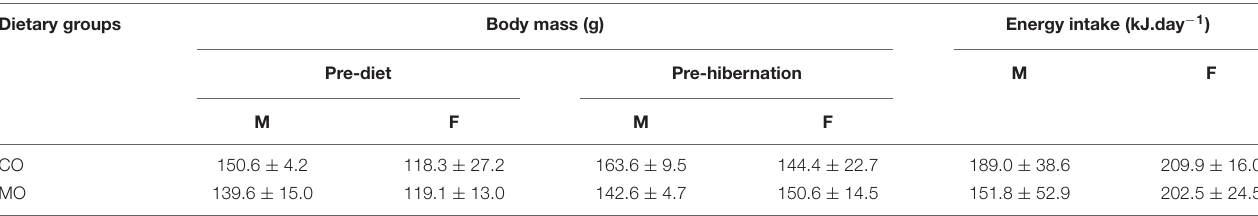
TABLE 3 | Body mass (means ± standard deviation) at the start of the diet treatment (“Pre-diet”) and prior to hibernation (“Pre-hibernation”), and energy intake (means ± standard deviation) during the diet treatment of male (“M”) and female (“F”) garden dormice fed diets enriched with either n-6 fatty acids (“CO”) or n-3 fatty acids (“MO”).